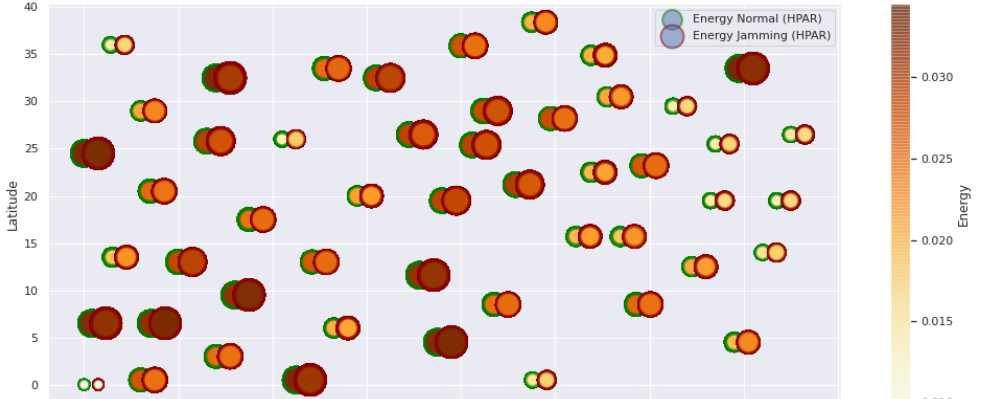
Figure 10. HPAR energy under normal conditions and